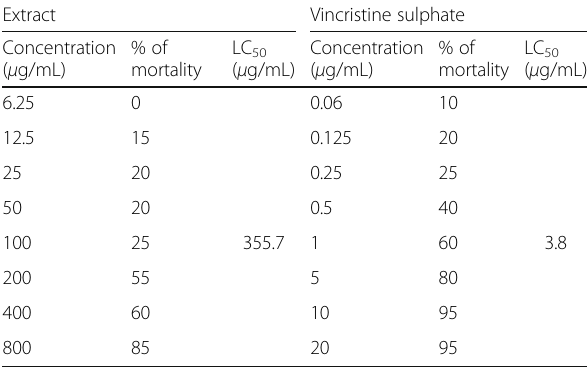
Table 4 Cytotoxic effect of MCFL and positive control vincristine sulphate on brine shrimp nauplii Extract Vincristine sulphate Concentration ( μ